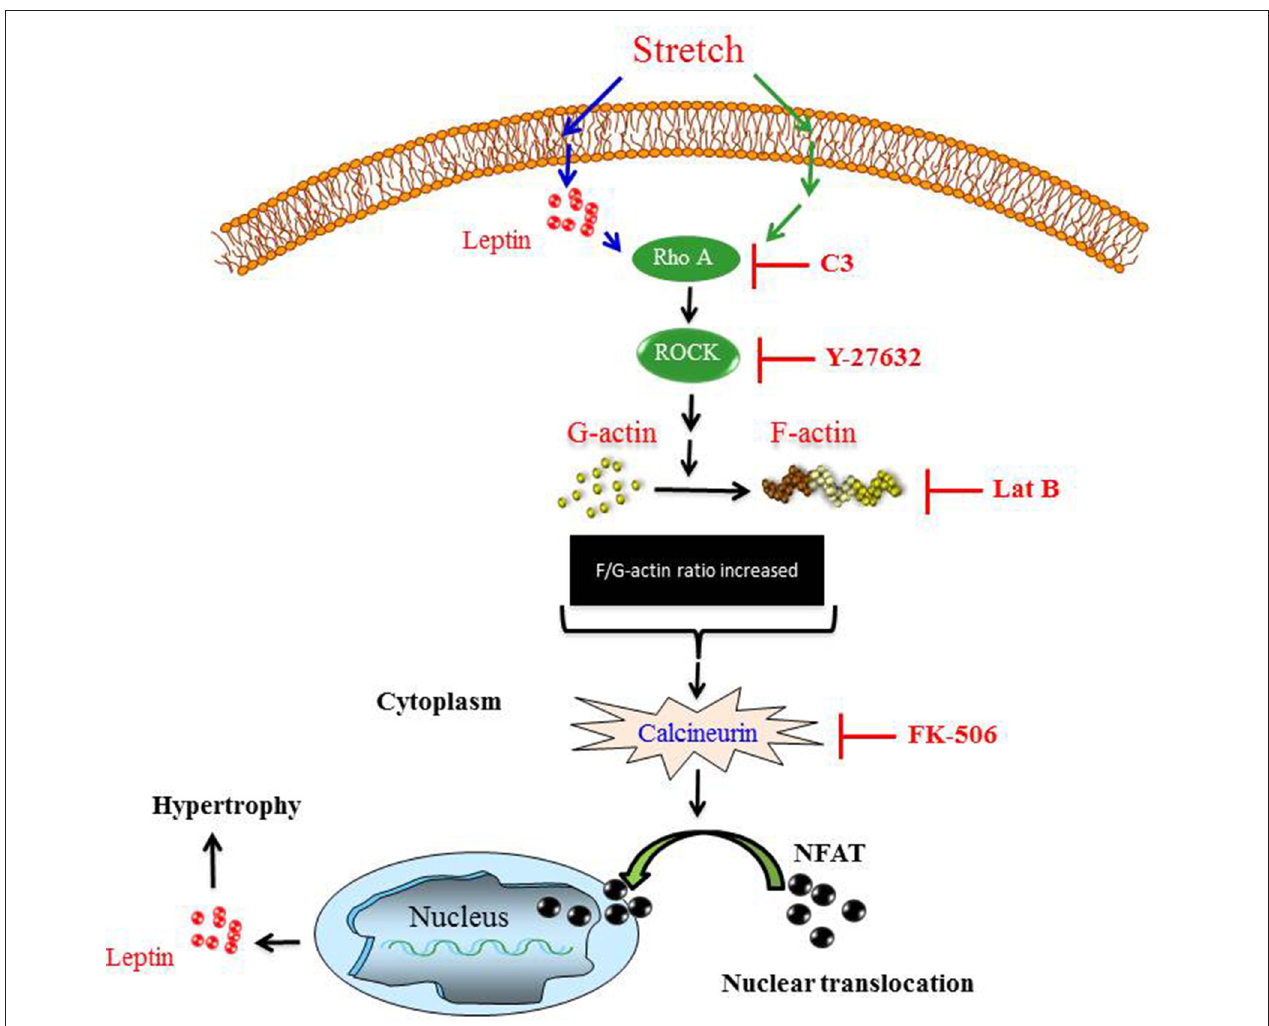
FIGURE 7 | The proposed mechanism of mechanical stretch-induced VSMC hypertrophy demonstrates that the RhoA/ROCK pathway activation, calcineurin activation, NFAT nuclear translocation, and leptin synthesis are involved in this process.